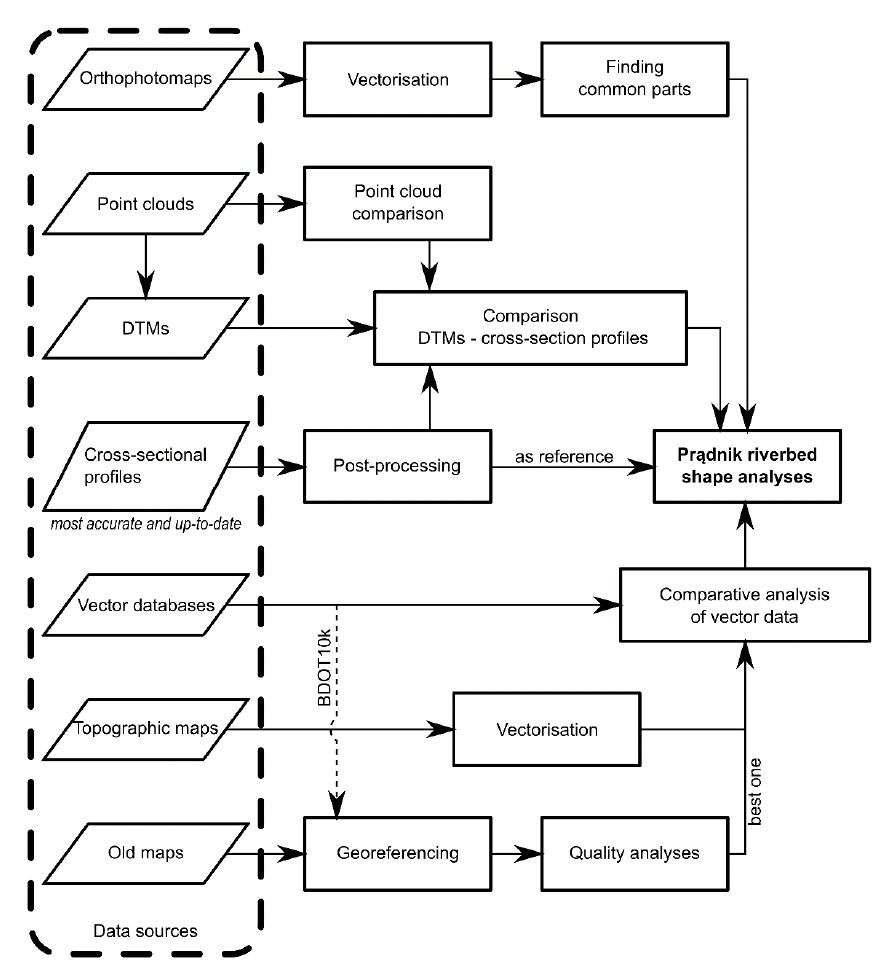
Figure 2. Flowchart of used data and methods.